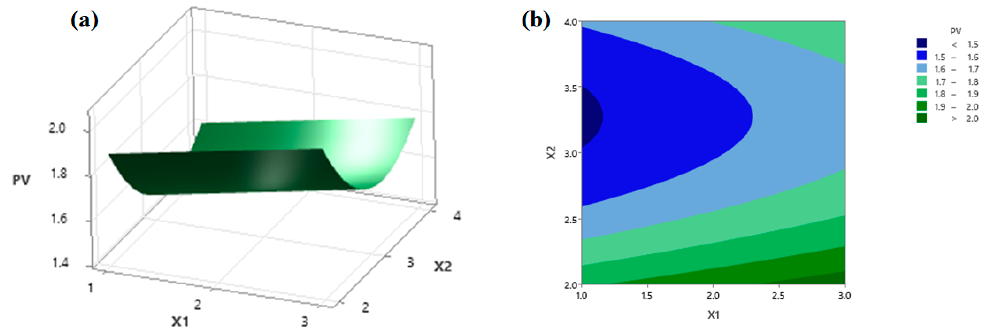
Figure 5. The response surface ( a ) and contour plots ( b ) as a function of independent variables on the PV. X 1 and X 2 represent the NaCl concentration and liquid-to-solid ratio, respectively.